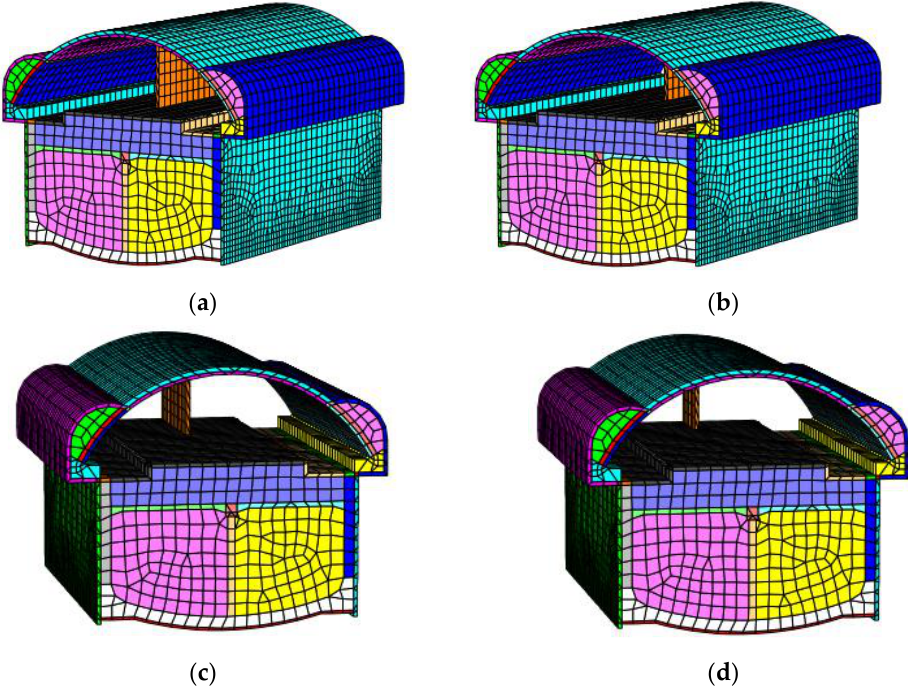
Figure 9. Numerical model of demolition of partition walls in different length: ( a ) dismantle 6 m; ( b ) dismantle 12 m; ( c ) dismantle 18 m; ( d ) dismantle 24 m.